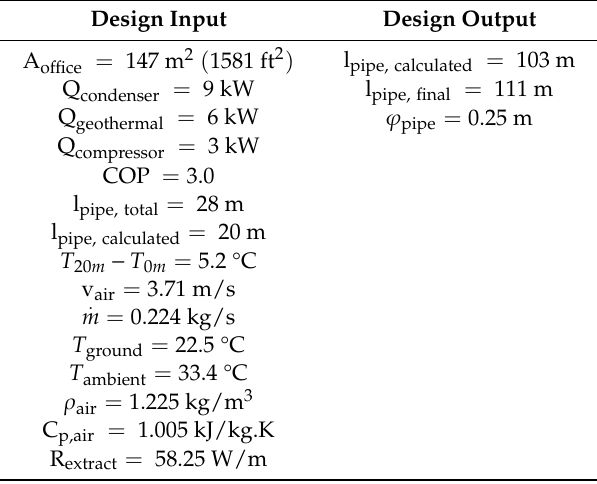
Table 7. Design input and output of the o ffi ce space calculation for a target COP of